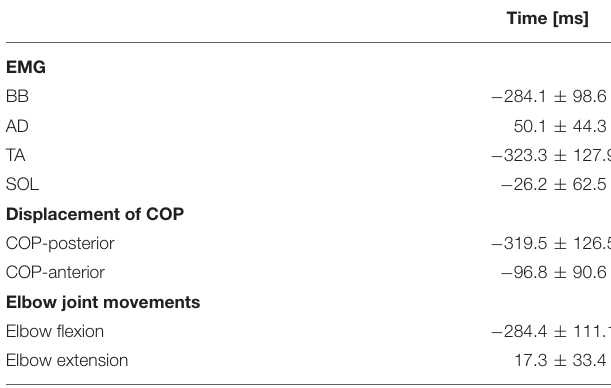
TABLE 1 | EMG and the onset of the kinematic parameters are aligned to the TB onset.